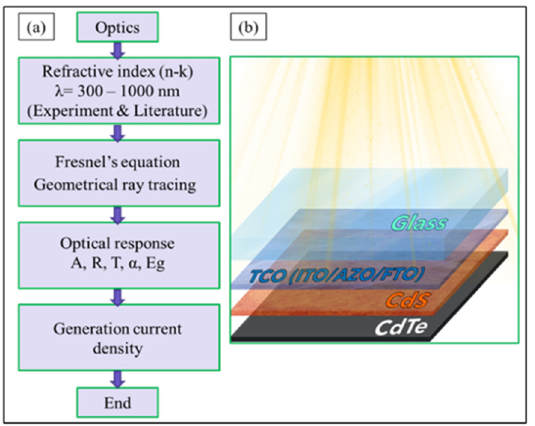
Figure 1. ( a ) Flow chart of OPAL2 simulation, ( b ) layer configuration of the CdTe thin film.